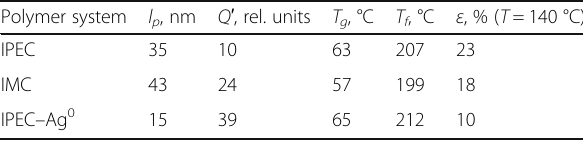
Table 1 Structural parameters and temperature transitions for the investigated polymer